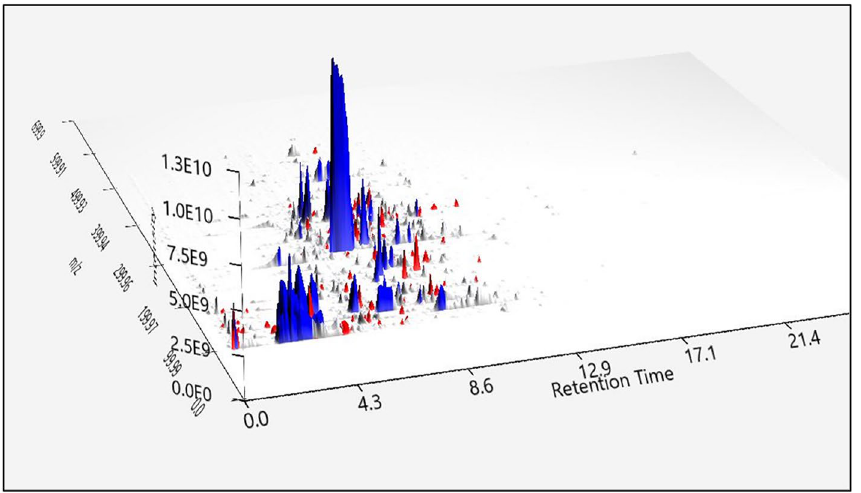
Figure 1. 3D chromatogram of the representative extracts using 3D visualizer. RED, alkaloid extract; BLUE, nonalkaloid extract. The X-axis shows the retention time, the Y-axis shows the m/z value, and the Z-axis shows the